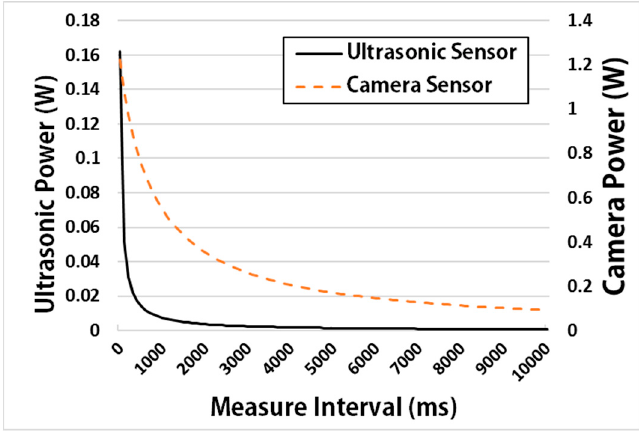
Figure 14. Power (Watt) of an ultrasonic sensor and camera sensor according to measure interval.